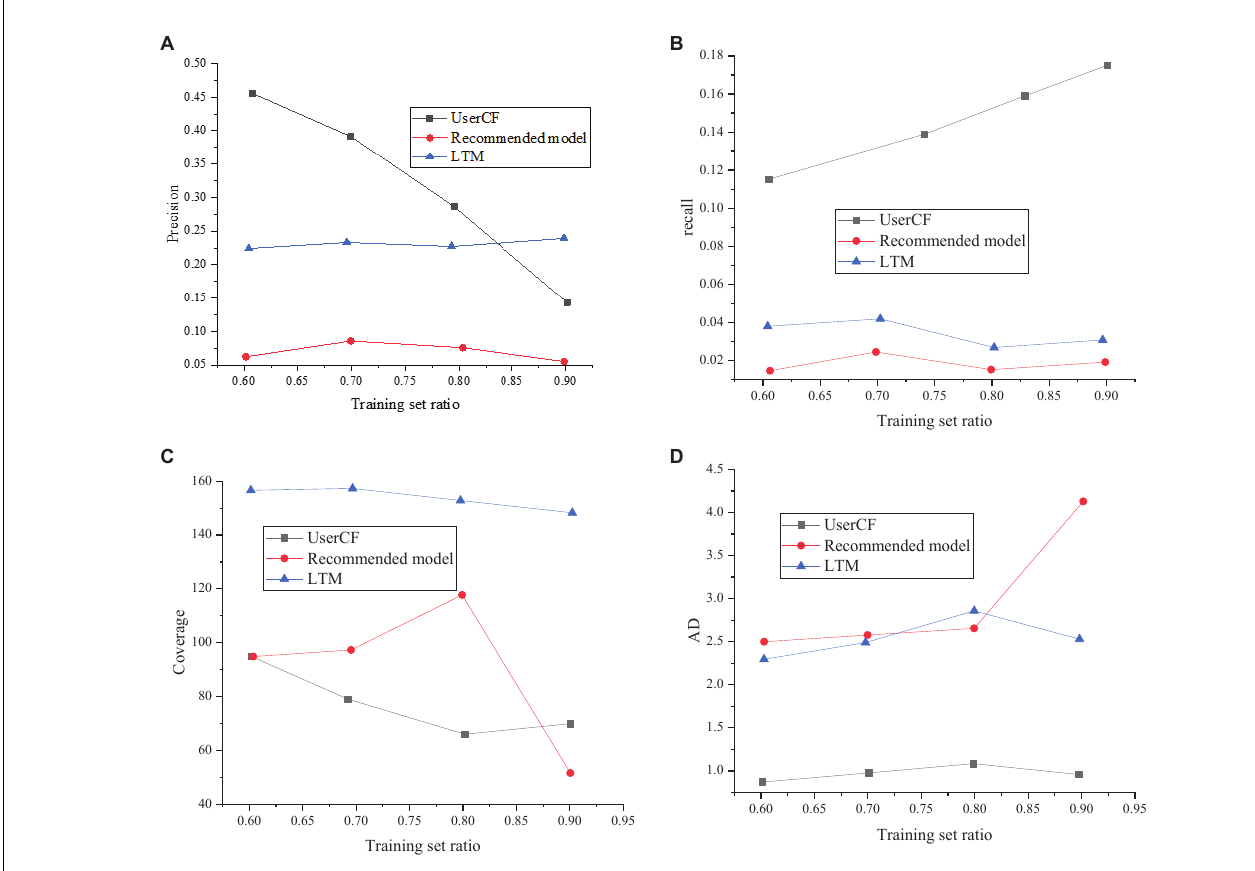
FIGURE 8 | Performance verification and comparison results. (A) The accuracy comparison result; (B) the recall ratio (recall) comparison result; (C) the coverage ratio (Coverage) comparison result; (D) the average difficulty (AD) comparison